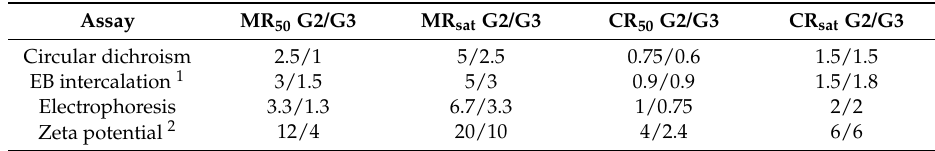
Table 1. Parameters of siRNA complexation by dendrimers BDEF32 (G2) and BDEF33 (G3), as calculated from the biophysical